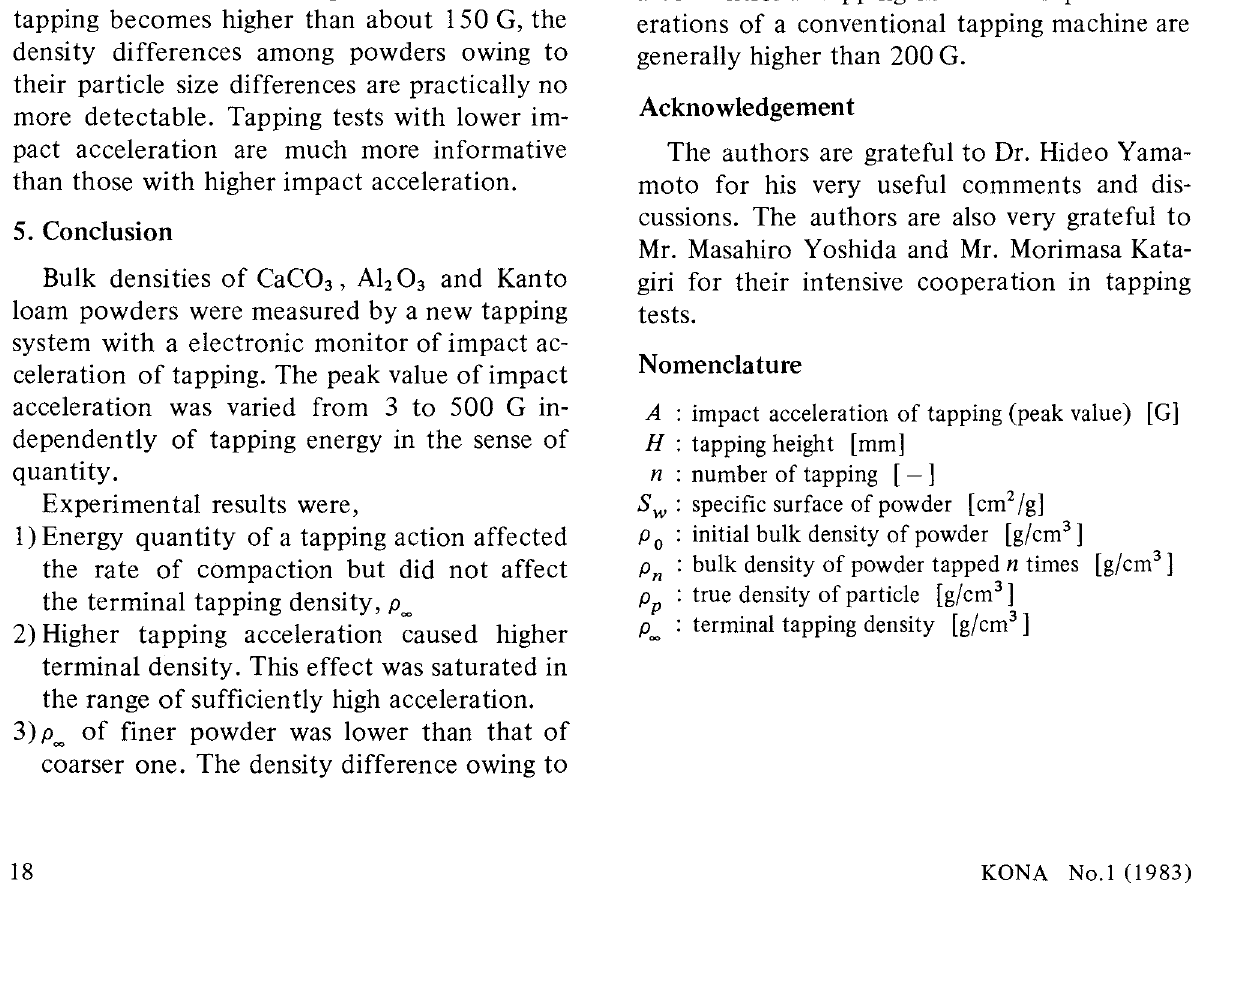
Fig. 7 Terminal tapping densities of white alundum powders